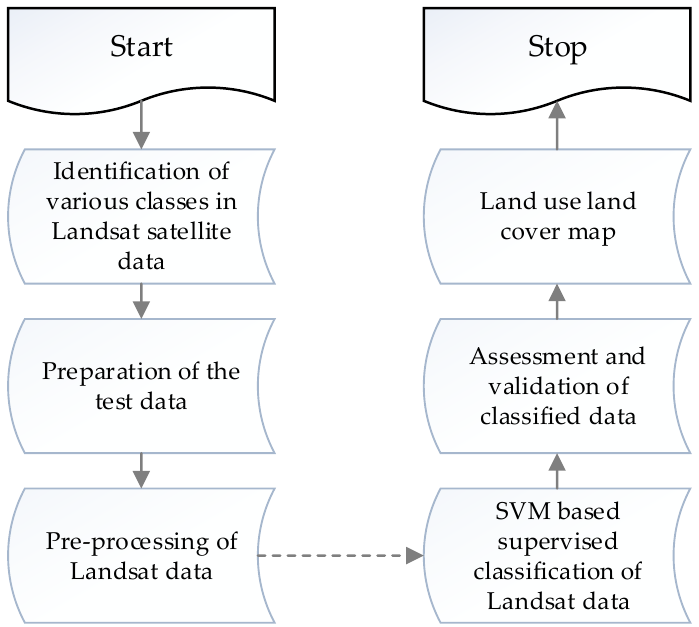
Figure 5. Flowchart for construction of Land Use Land Cover (LULC) map from Landsat data.